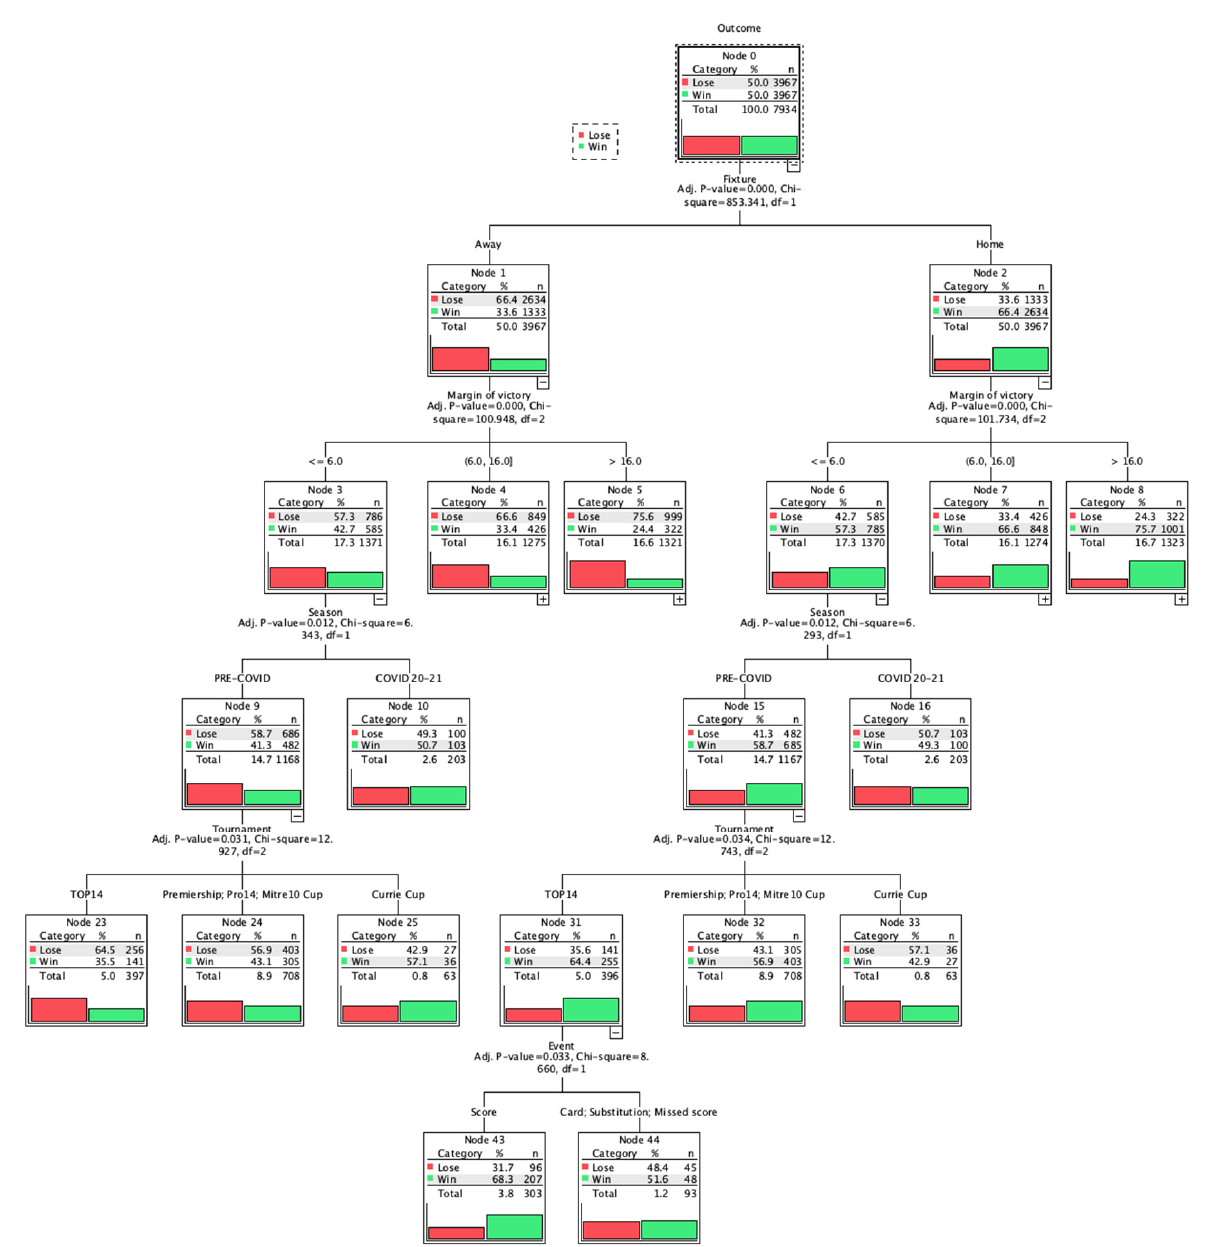
Figure 2. Closed Games Diagram from the Away and Home Fixture Perspective. From the fixture perspective (node 1–2) teams playing at home were 66.4% likely to win the game. At the second level of depth (nodes from 3 to 8), the values of the margin of victory were divided into 3 clusters, below 6 points for closed, from 6 to 16 for balanced, above 16 for unbalanced games,